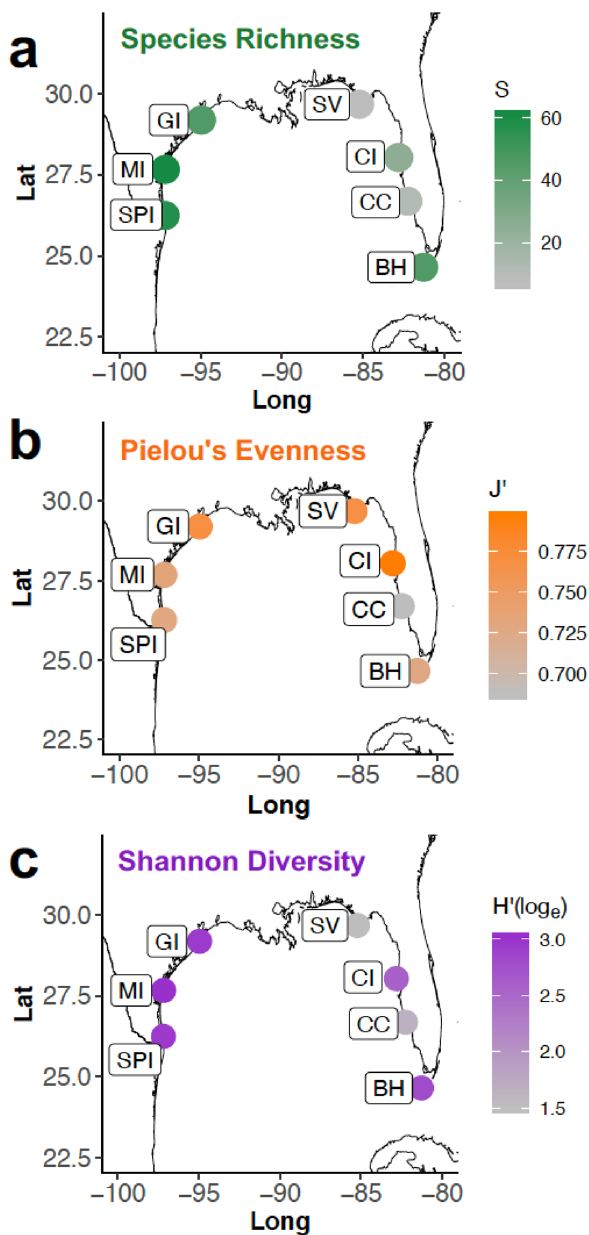
Figure 4. ( a ) Species richness, ( b ) Pielou’s evenness and ( c ) Shannon diversity by site as calculated from T-RFLP species richness and relative abundance data. Data used to generate figure are provided in Supplementary Table